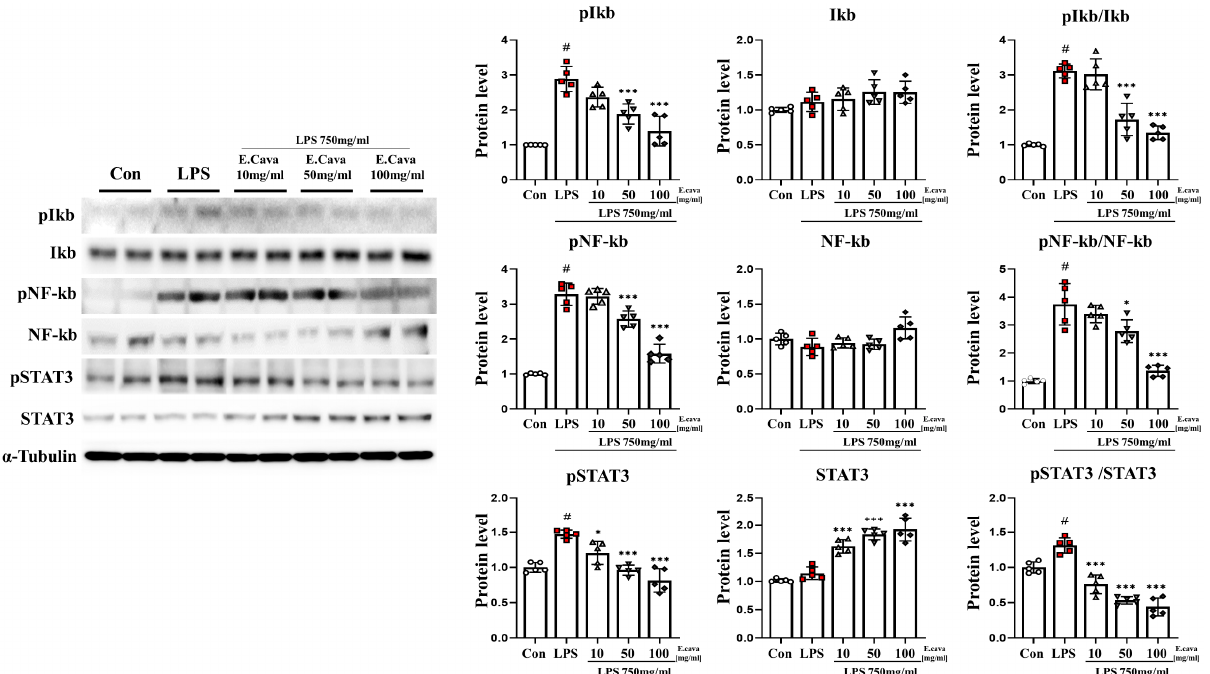
Figure 2. E. cava reduces inflammation-regulated markers in the cerebrum. Western blot analysis and quantification of inflammation-regulated related genes were evaluated in the cerebrum of each group of male mice. Alpha-Tubulin was used for internal control. The points on the graph are represented by different shapes, with a white circle indicating the control group, a red square indicating the LPS group, a triangle representing the LPS + E. cava 10 mg/kg group, an inverted triangle indicating the LPS + E. cava 50 mg/kg group, and a rhombus representing the LPS + E. cava 100 mg/kg group. The differences between means were obtained through one-way ANOVA, and then a Tukey post-analysis. The values represent means ± S.D. # p < 0.001 vs. control group and * p < 0.05, *** p < 0.01 vs. LPS